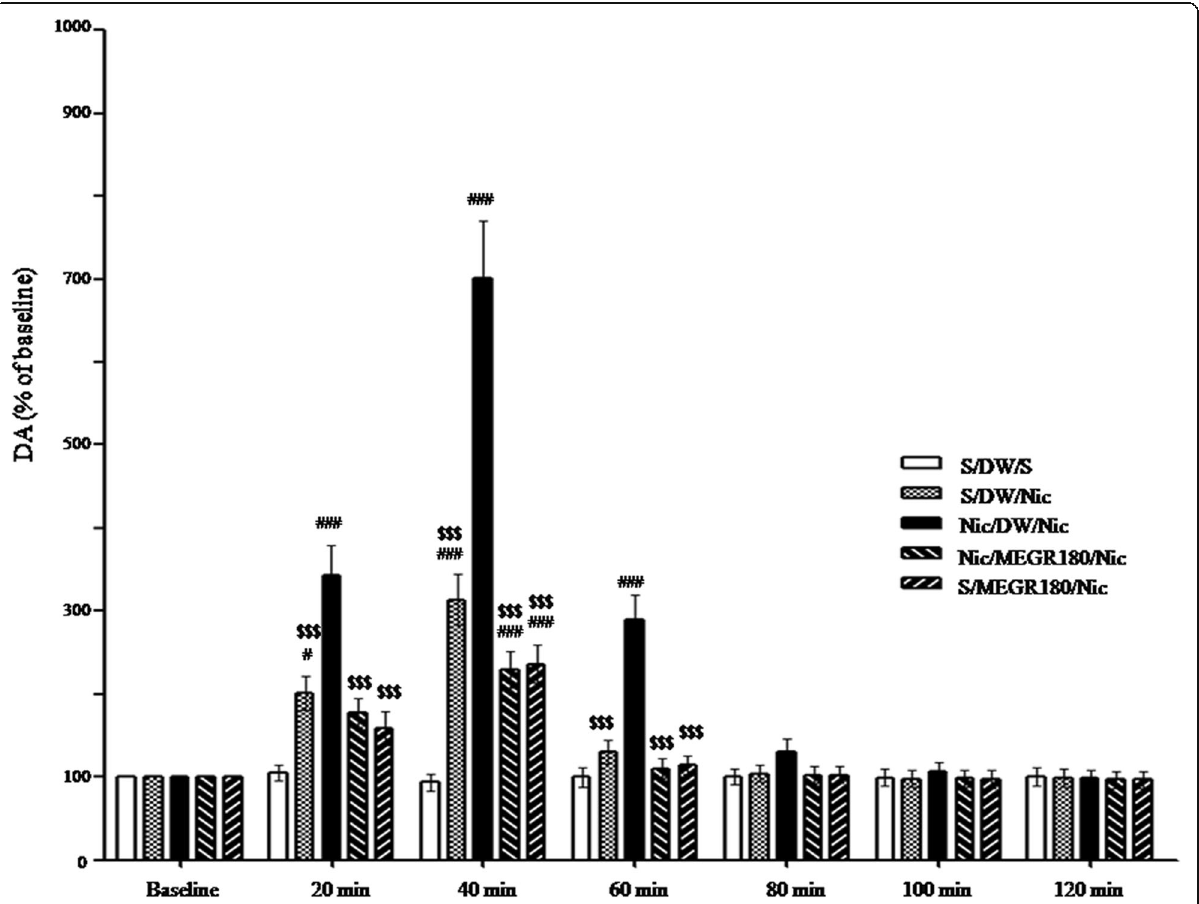
Fig. 2 Effects of MEGR on extracellular DA levels in the NaccSh. On the 4th after the last nicotine (Nic) injection, rats were challenged with a direct intra-NaccSh infusion of 3.0 mM Nic, and during the withdrawal period the rats were treated with MEGR. All data are expressed as means ± SEM ( n = 5 – 6). Nic: nicotine, S: saline, MEGR: methanol extract of G. radix , MEGR180: 180 mg/kg/day MEGR once a day for 4 consecutive days. # P < 0.05, ### P < 0.001 versus S/DW/S group; $$$ P < 0.001 versus Nic/DW/Nic group (two-way ANOVA followed by the Bonferroni post-hoc